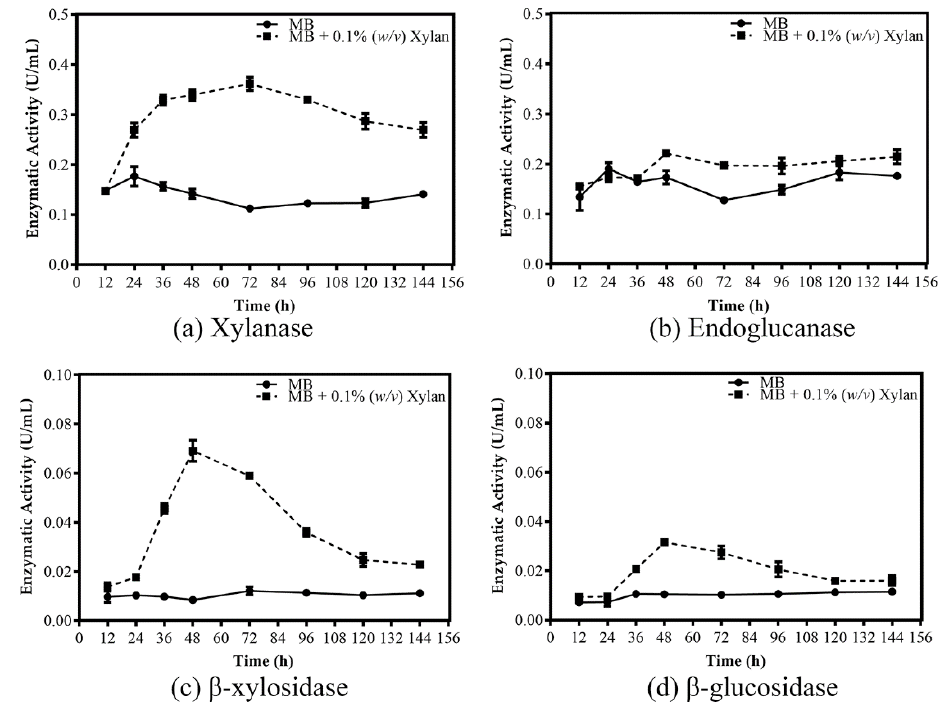
Figure 2. Enzyme activity of R. sacchariphilus strain RA crude lysate throughout its growth profile. ( a ) Xylanase; ( b ) endoglucanase; ( c ) β -xylosidase; ( d ) β -glucosidase activities. 211